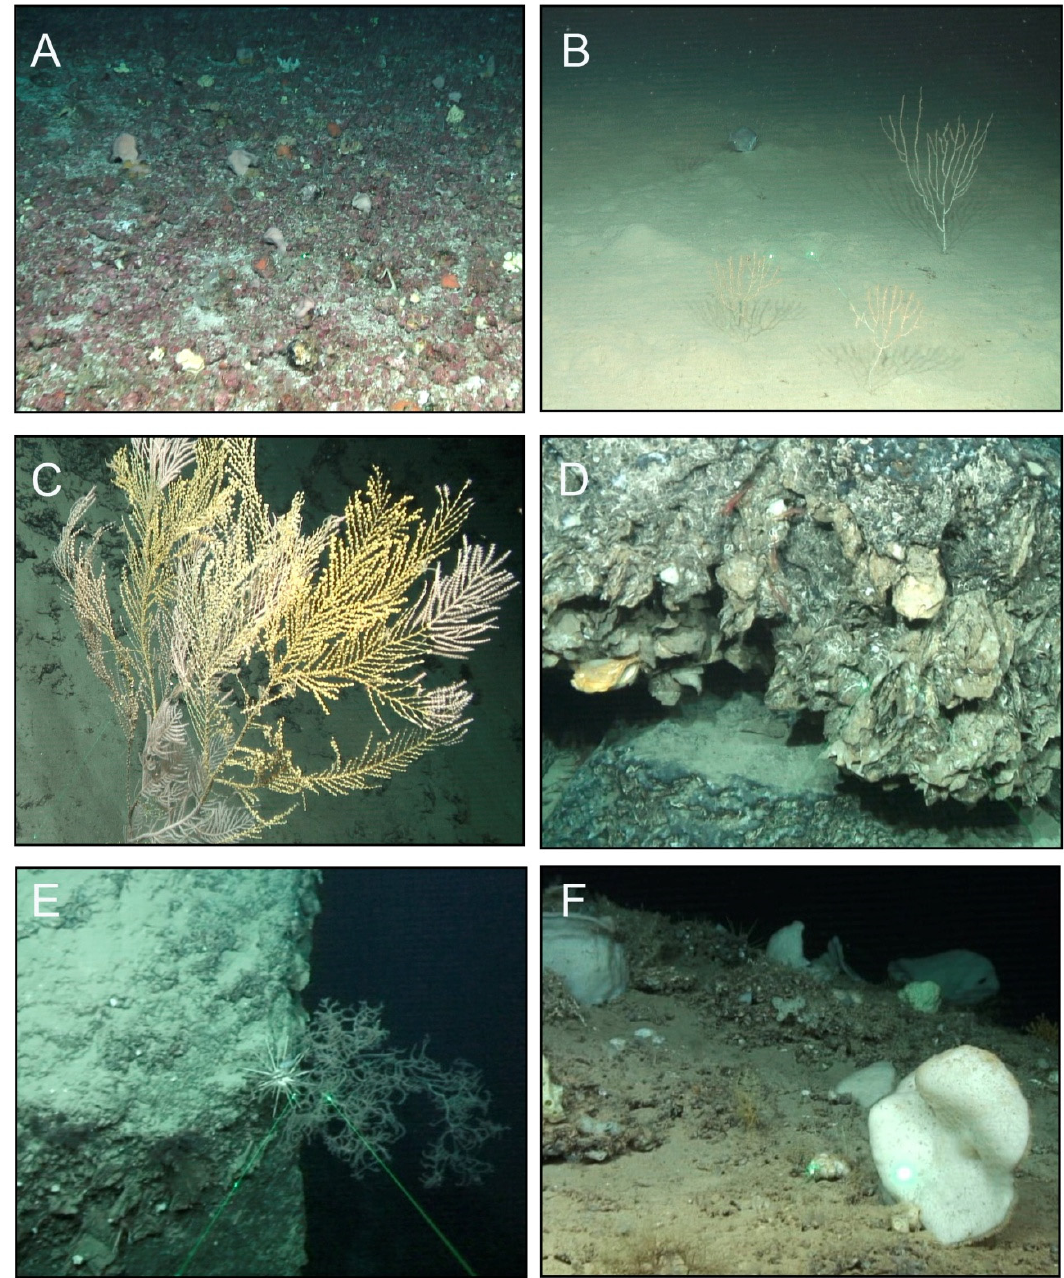
Figure 9. Habitats and biological communities identified in the Ses Olives (SO), Ausias March (AM), and Emile Baudot (EB) seamounts of the Mallorca Channel (Balearic Islands, western Mediterra- nean): ( A ) Rhodolith beds in EB at 113 m depth); ( B ) bathyal muds with Alcyonacea ( Isidella elongata ) in SO at a 590 m depth; ( C ) bathyal rock with Alcyonacea ( Callogorgia verticillata ) in EB at a 830 m depth; ( D ) upper bathyal biogenic Thanatocoenosis of giant ostreids in EB at a 417 m depth; (E) bathyal rock with Anthipataria ( Leiopathes glaberrima ) in EB at a 491 m depth; and ( F ) bathyal rocky bottoms with coarse sediments dominated by sponges in AM at a 365 m depth.